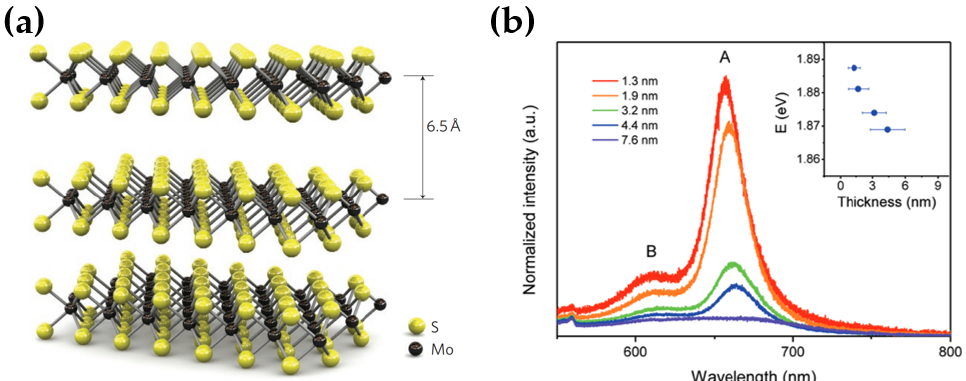
Figure 4. ( a ) Three-dimensional schematic representation of a typical MX 2 structure, with the chalcogen atoms (X) in yellow and the metal atoms (M) in grey [71] (Reproduced with permission from ref. [71]. Copyright 2016 Springer Publications.); ( b ) photoluminescence spectra of MoS 2 thin films with average thicknesses ranging from 1.3 to 7.6 nm (Reproduced with permission from ref. [73]. Copyright 2011 ACS Publications).